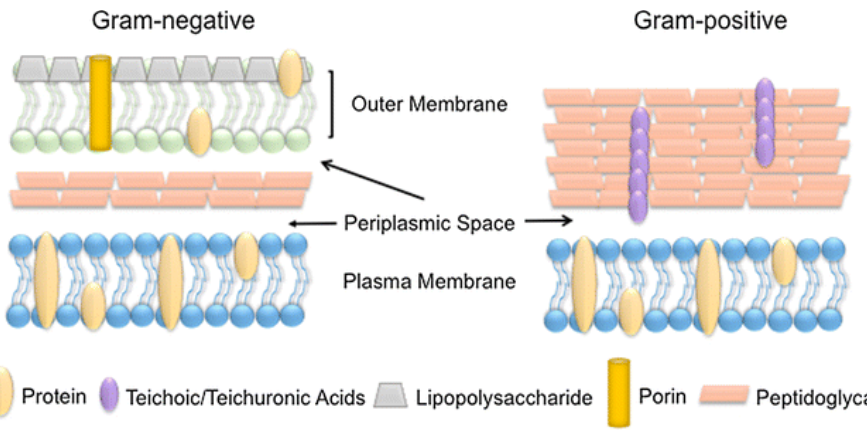
Figure 2. Gram-negative and positive bacteria